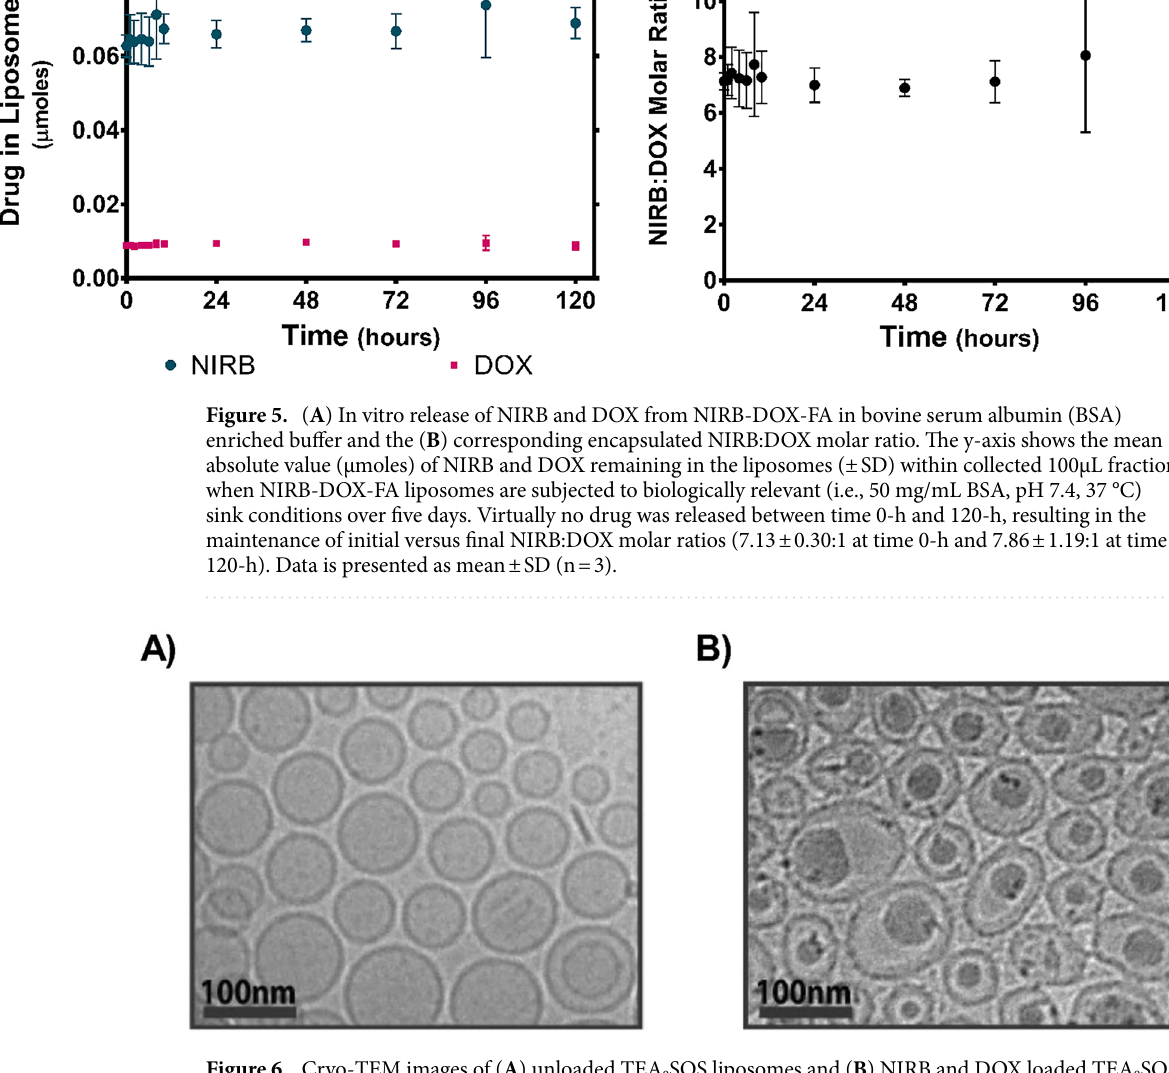
Figure 6. Cryo-TEM images of ( A ) unloaded TEA 8 SOS liposomes and ( B ) NIRB and DOX loaded TEA 8 SOS liposomes. Darker versus lighter areas demonstrate the presence of a greater versus lower electron density, respectively. Comparing images of loaded versus unloaded liposomes, drug loaded liposomes exhibit dark, electron dense deposits at the core. These deposits may be due to precipitated drug in the liposomal previous work done in our group which showed a similar antagonistic pattern with the OLP and DOX combina- tion across all tested molar ratios 30 . These findings are in stark contrast to the synergistic/additive profile of the NIRB and DOX combination shown in the PEO1 cell line. This comparison is critical to our understanding of PARPi and DOX combinations as PEO1 and PEO4 are sister cell lines that were derived from the same patient at different points of disease progression. The PEO1 cell line was obtained from the patient at the stage of primary tumor debulking following one round of neoadju- vant chemotherapy (cisplatin, 5-FU, and chlorambucil) while the PEO4 cell line was derived from bulk tumor removed during the secondary tumor debulking after the development of clinical resistance to the aforemen- tioned chemotherapy 32 . Inspection of the PEO1 and PEO4 sister pair reveals a BRCA2 mutation reversion to wild-type that is present in the PEO4 cell line 33 . Given that BRCA2 works exclusively on the HR repair pathway, we hypothesize that the observed synergy for the NIRB and DOX combination is highly dependent on HR repair deficiency 34 . However, additional studies are needed to support this hypothesis. These results suggest that a synergistic effect for the combination of NIRB and DOX is both cell line and molar ratio dependent. Translation of this combination to the clinic would thus likely need to be in conjunction with criteria for identifying patients likely to respond to this therapy. In the case of OLP, during AstraZeneca’s 2014 Phase I trial, the oral PARPi OLP and intravenous (IV) pegylated liposomal doxorubicin (PLD) combination